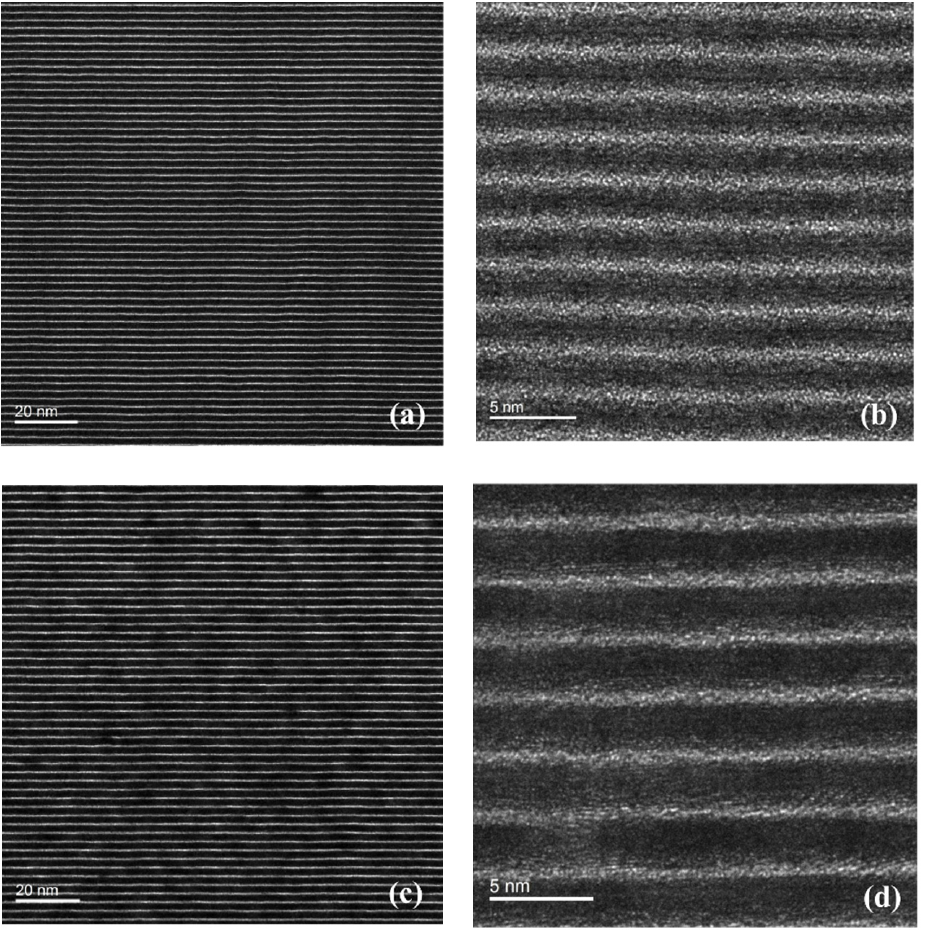
Figure 7. Cross-section TEM images of the as-deposited ( a , b ) and 700 °C annealed ( c , d ) Ru/C mul- tilayers.